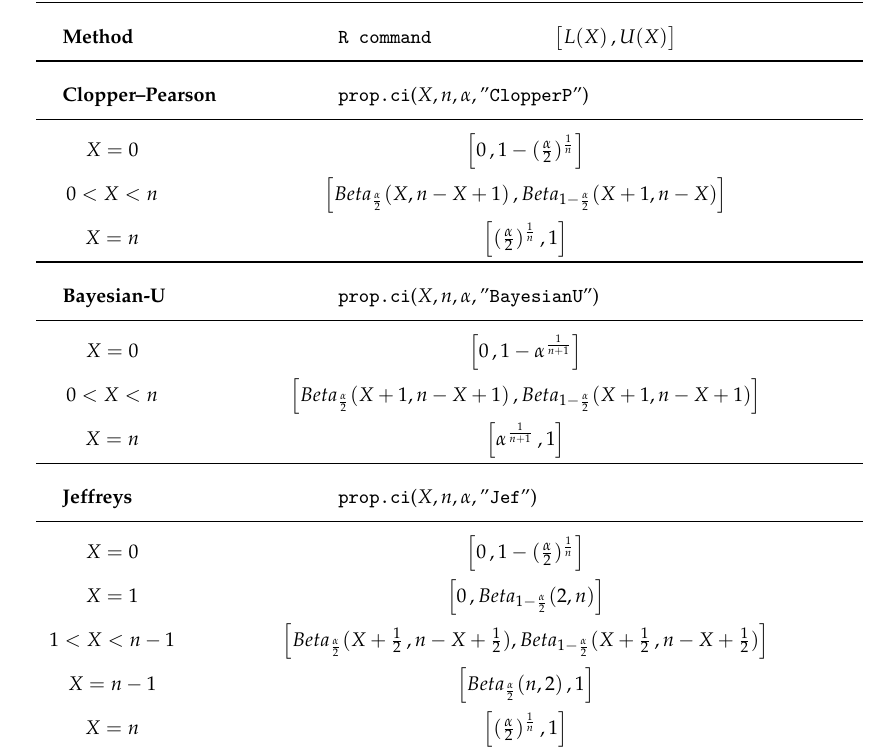
Table A1. Two-sided 100 × ( 1 − α ) % confidence intervals for a binomial proportion, [ L ( X ) , U ( X )] , where X is the number of successes, and R